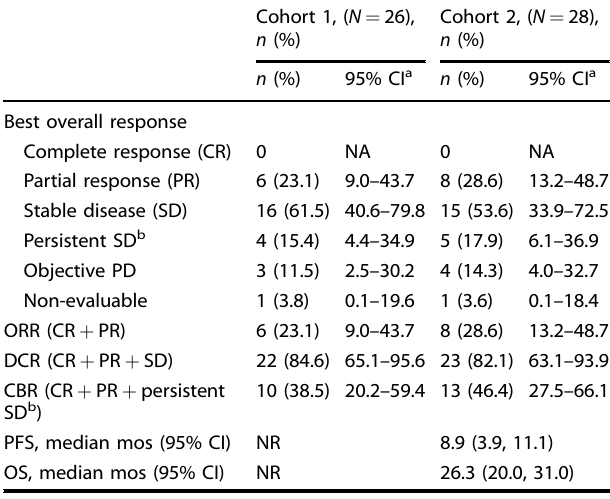
Table 5. Summary of antitumor activity (safety